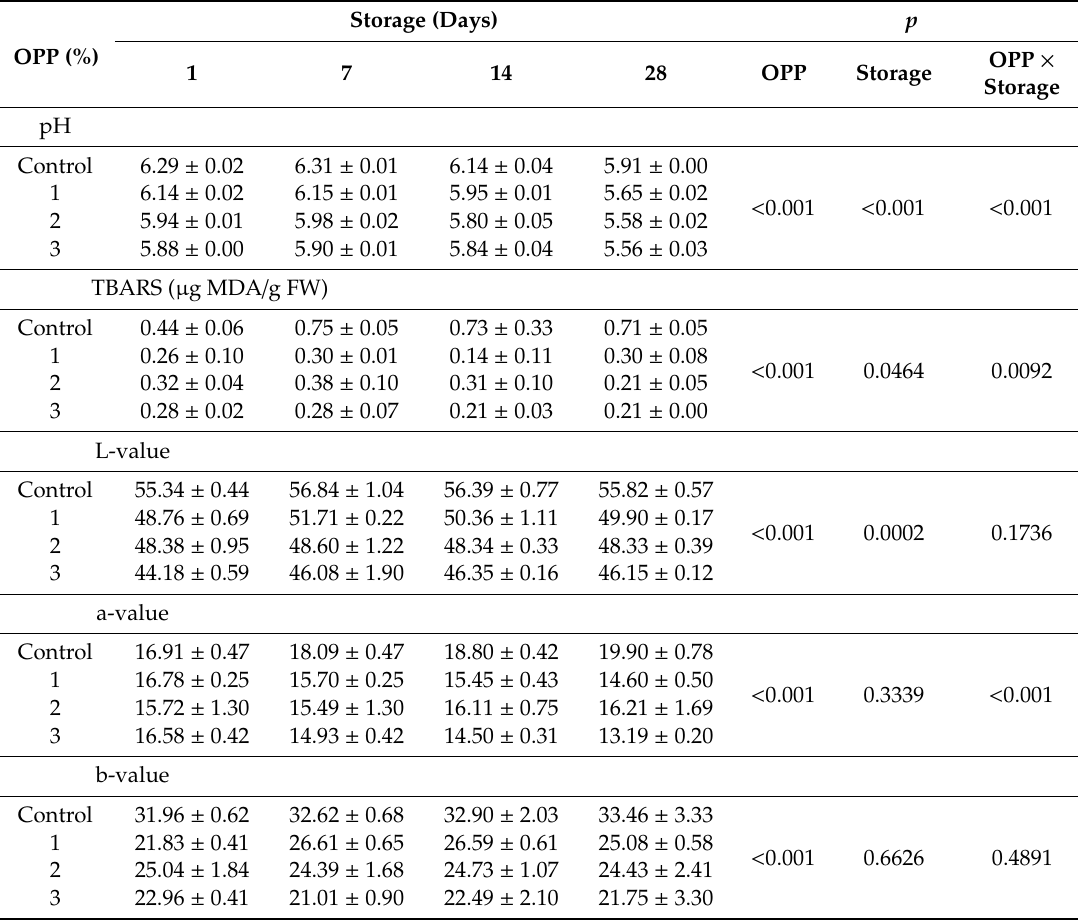
Table 2. Changes in pH, TBARS (thiobarbituric acid reactive substances), and color measurement values (L, a, and b) of fish sausages without (control) and with 1%, 2%, and 3% ( w / w ) of onion peel powder (OPP) during